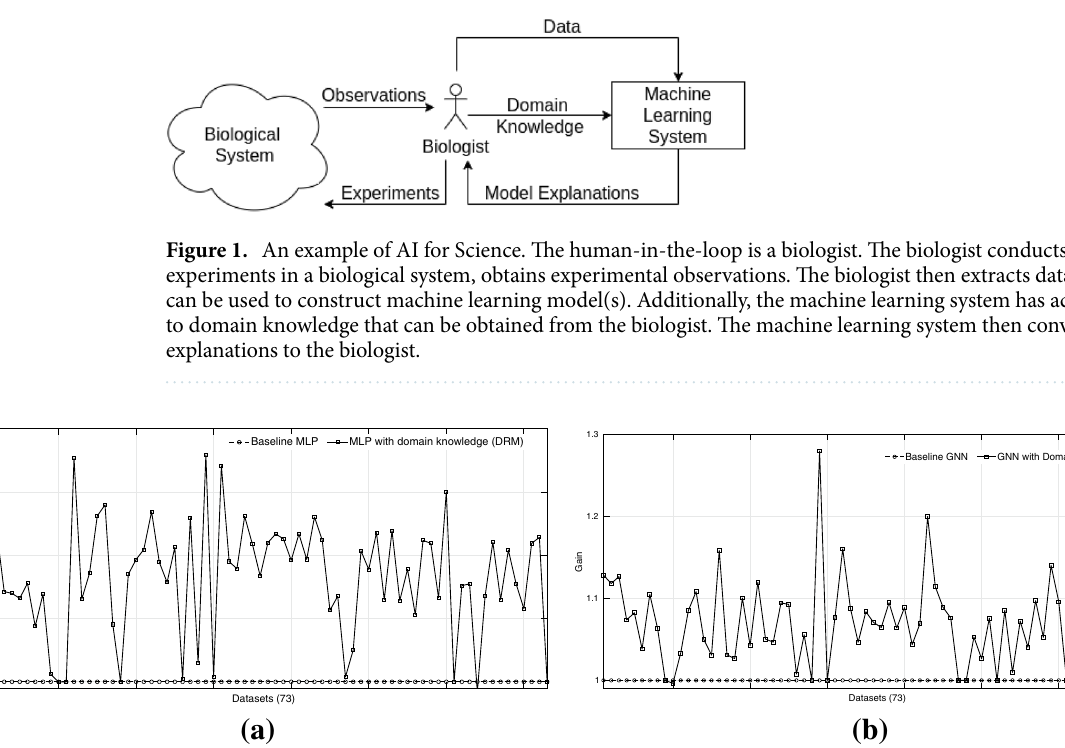
Figure 2. The plots from 6 showing gains in predictive accuracy of ( a ) multilayer perceptron (MLP), and ( b ) graph neural network (GNN) with the inclusion of domain-knowledge. The domain knowledge inclusion method in ( a ) is a simple technique known as ‘propositionalisation’ 7 ; and, the method in ( b ) is a general technique of incorporating domain-knowledge using bottom-graph construction. The results shown are over 70 datasets. No importance to be given to the line joining two points; this is done for visualisation purpose only.